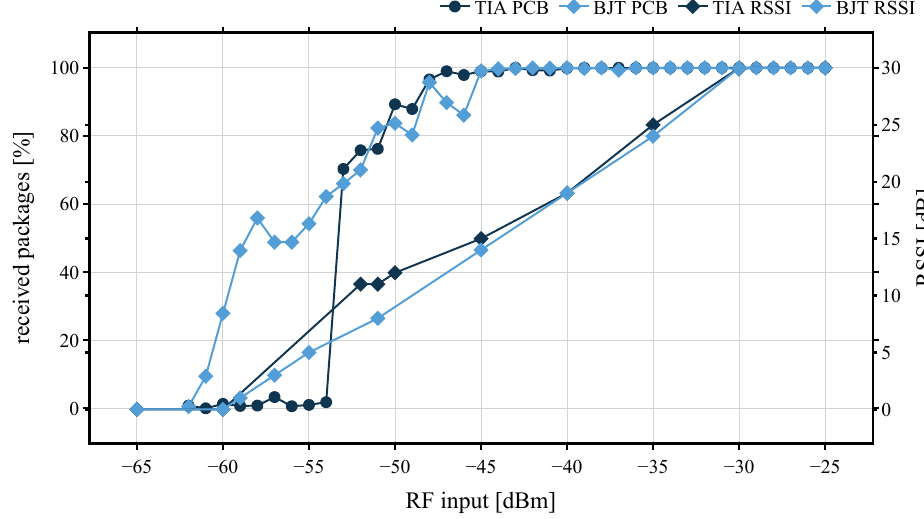
Figure 19. Packet error rate depending on input